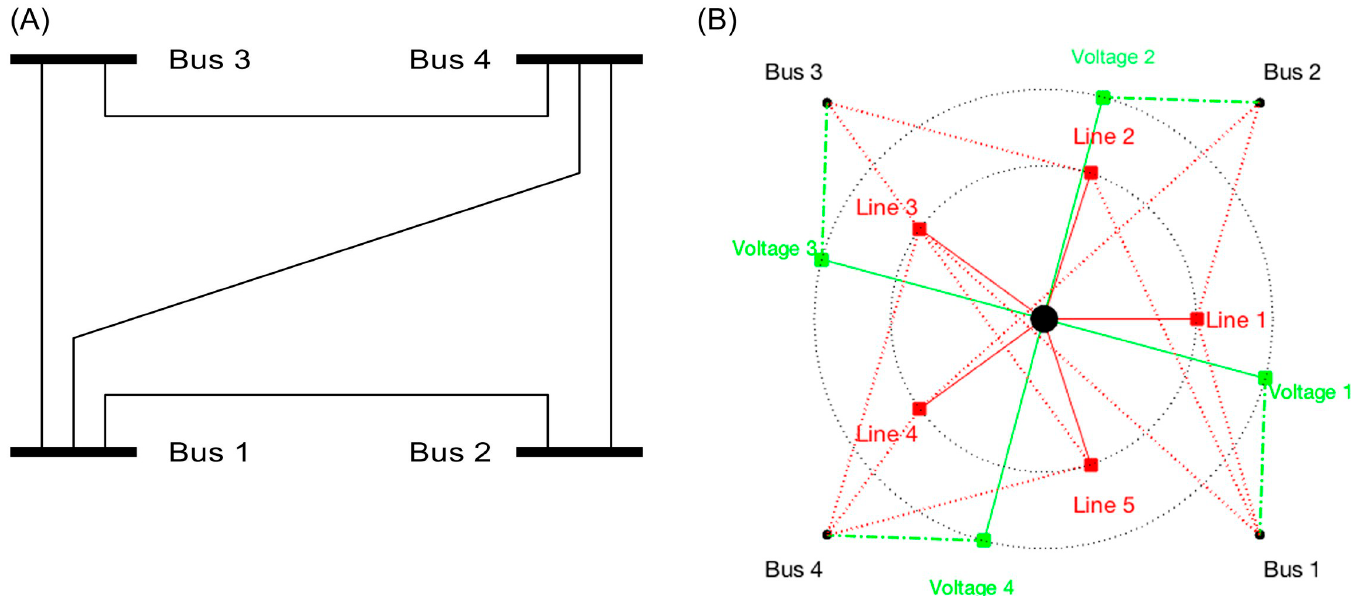
Fig 2. A star and linear network for a modified IEEE-4 bus system. The traditional network model is shown on the left (A) and the proposed network model is presented on the right (B). Red lines indicate the power channel, and green lines are the voltage channel.